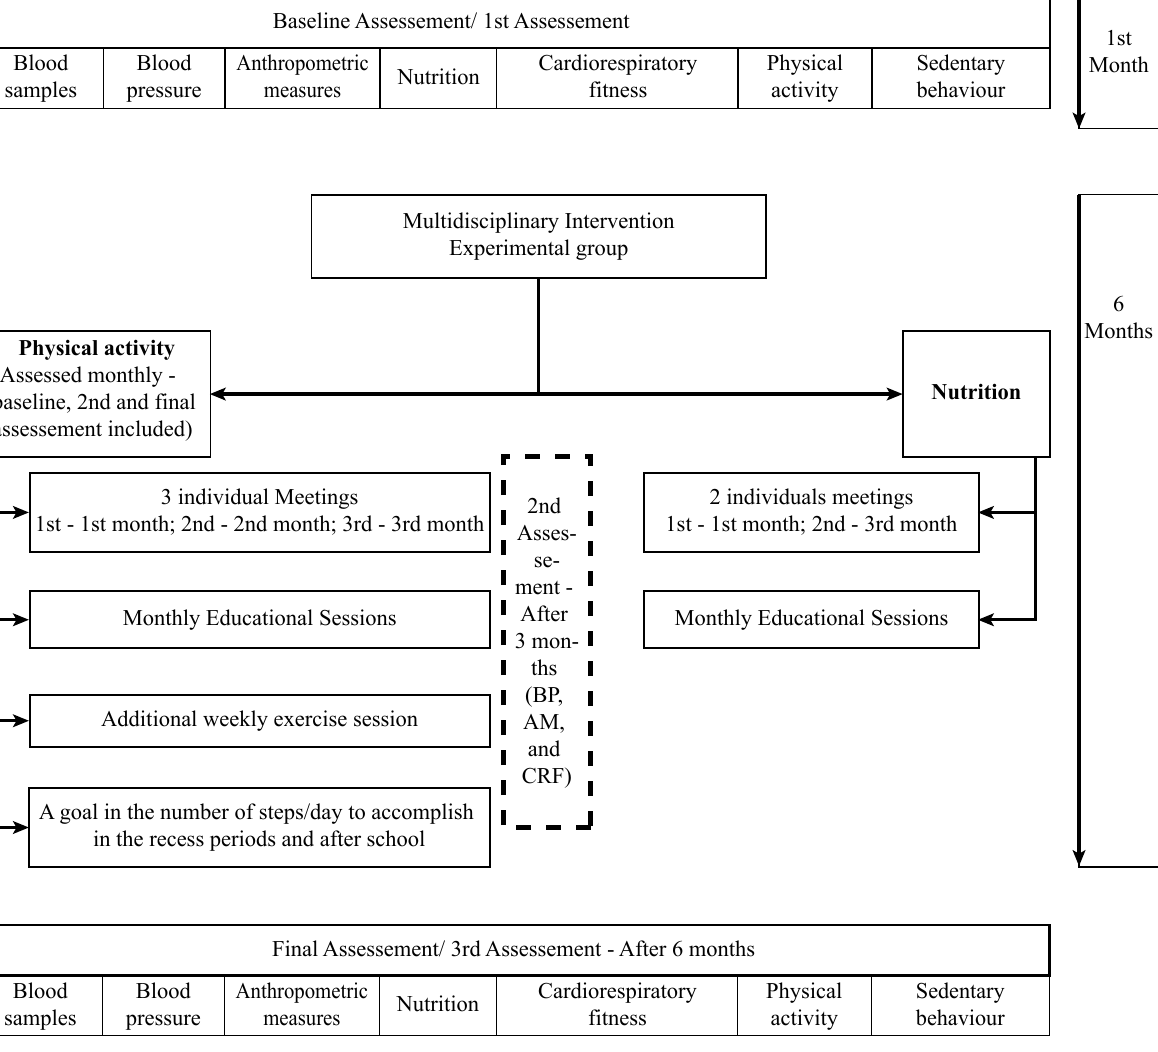
Fig. 2. Content and timeline of